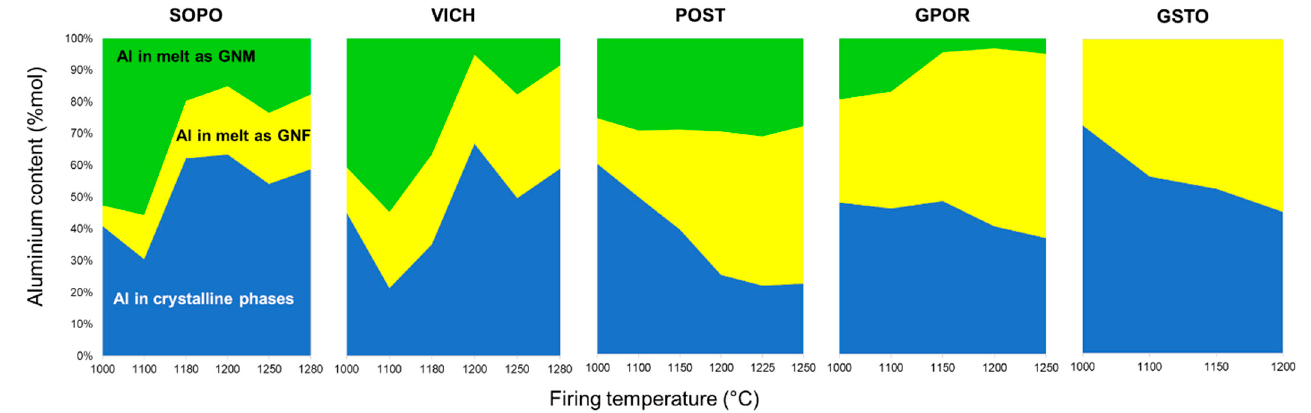
Figure 12. Speciation of Al in the bodies as a function of firing